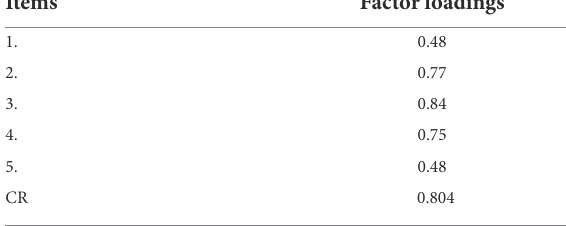
TABLE 3 Factor loadings for perceived academic intent to entrepreneurship (PAEI scale).